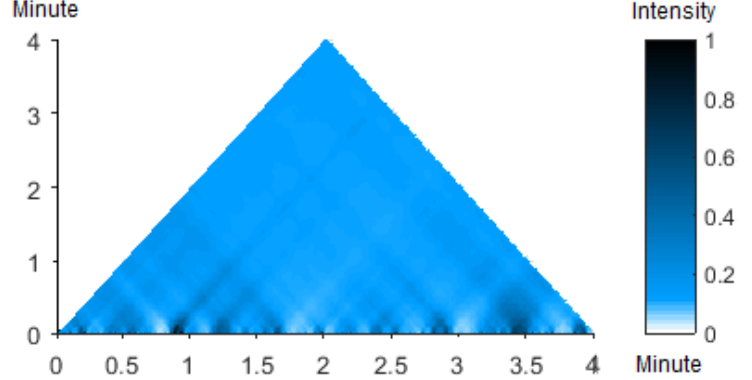
Figure 9. The global interaction intensities among all the players for the avoidance pattern.